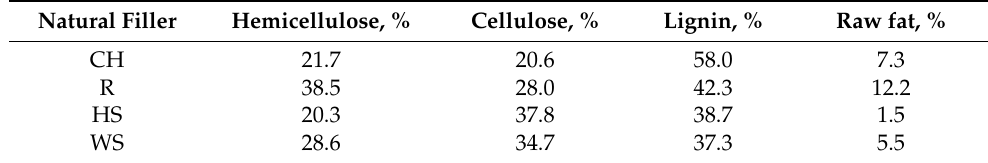
Table 2. The chemical composition of the natural fillers. Natural